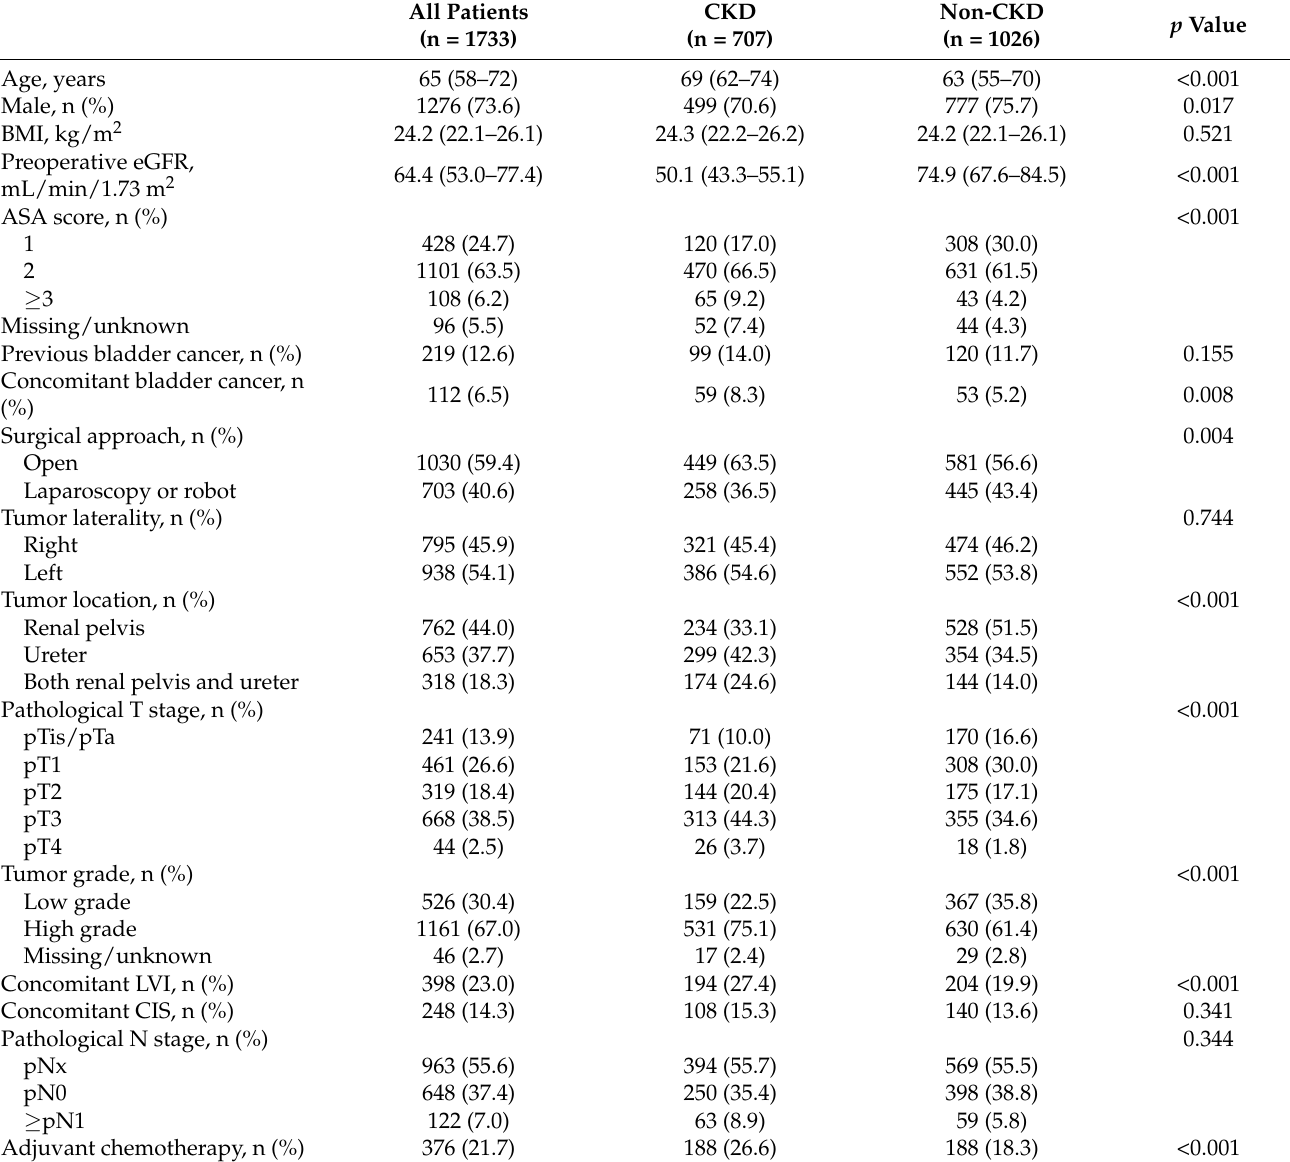
Table 1. Descriptive characteristics of 1733 patients treated with upper tract urothelial